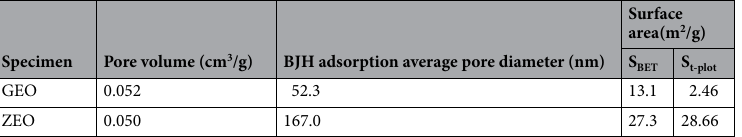
Table 3. Texture parameters of GEO and ZEO.